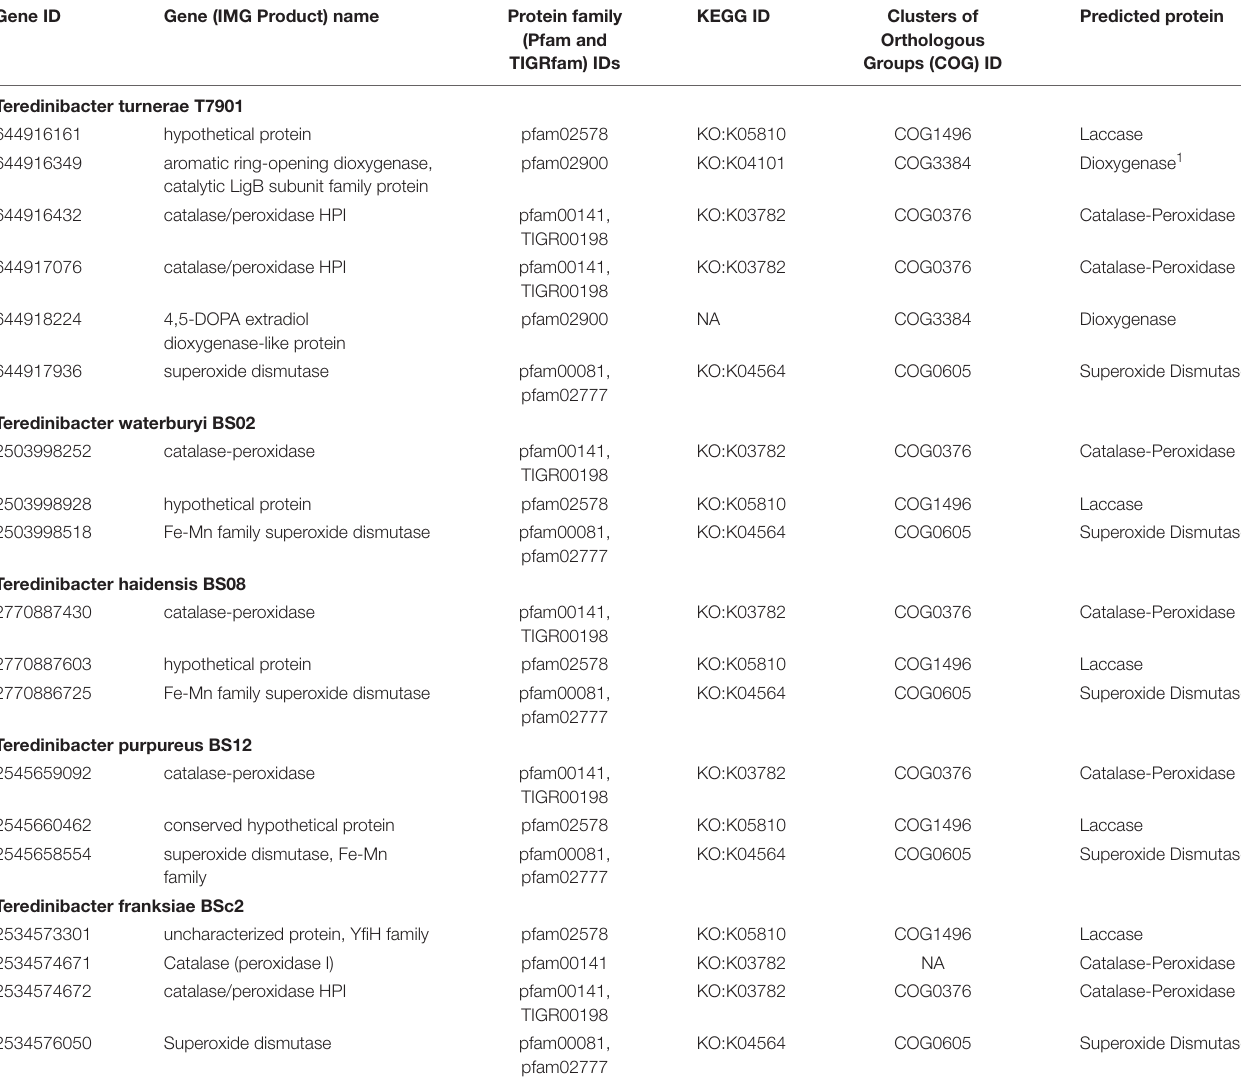
TABLE 2 | Symbiont genes possessing protein domains/regions matching functional IDs for putative bacterial ligninases from four protein family databases. Gene